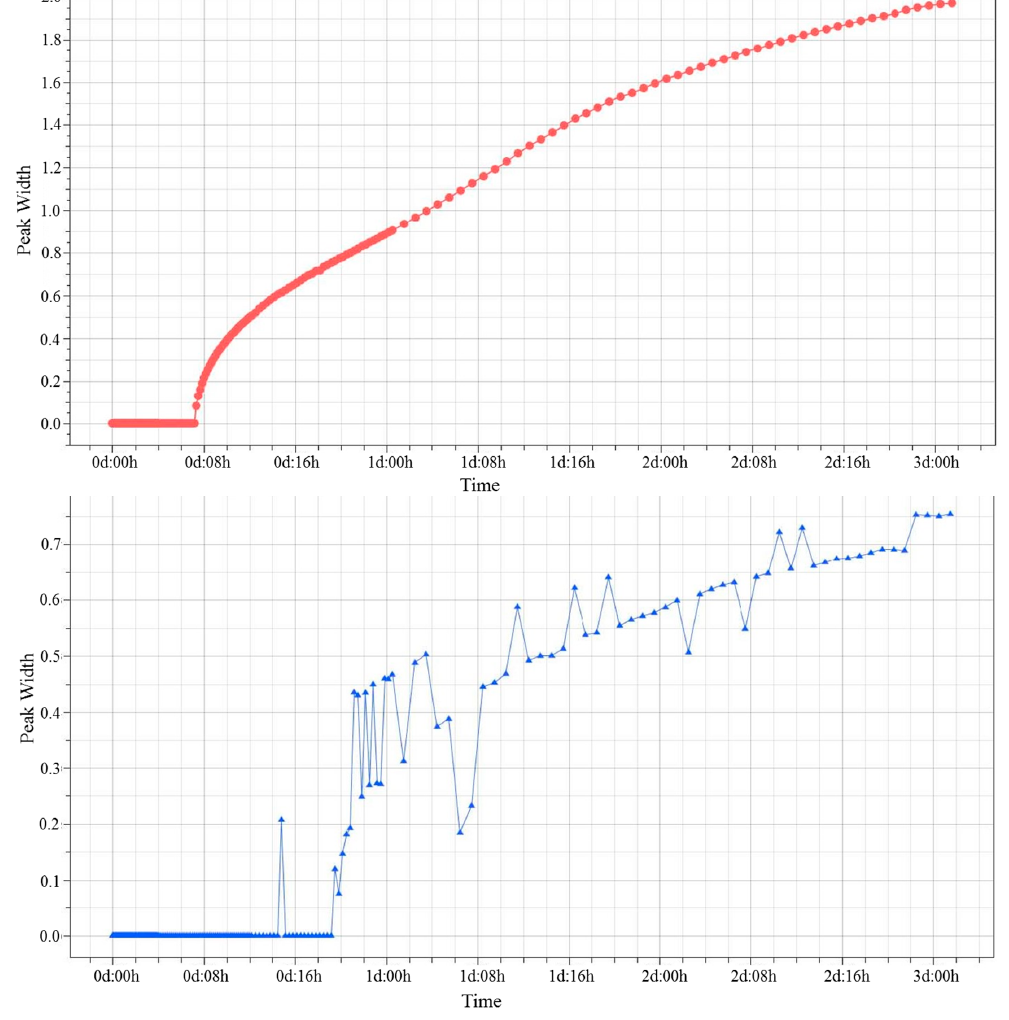
Figure 10. Peak’s width (BS) of F2 ( top ) and F3 ( bottom ) samples.